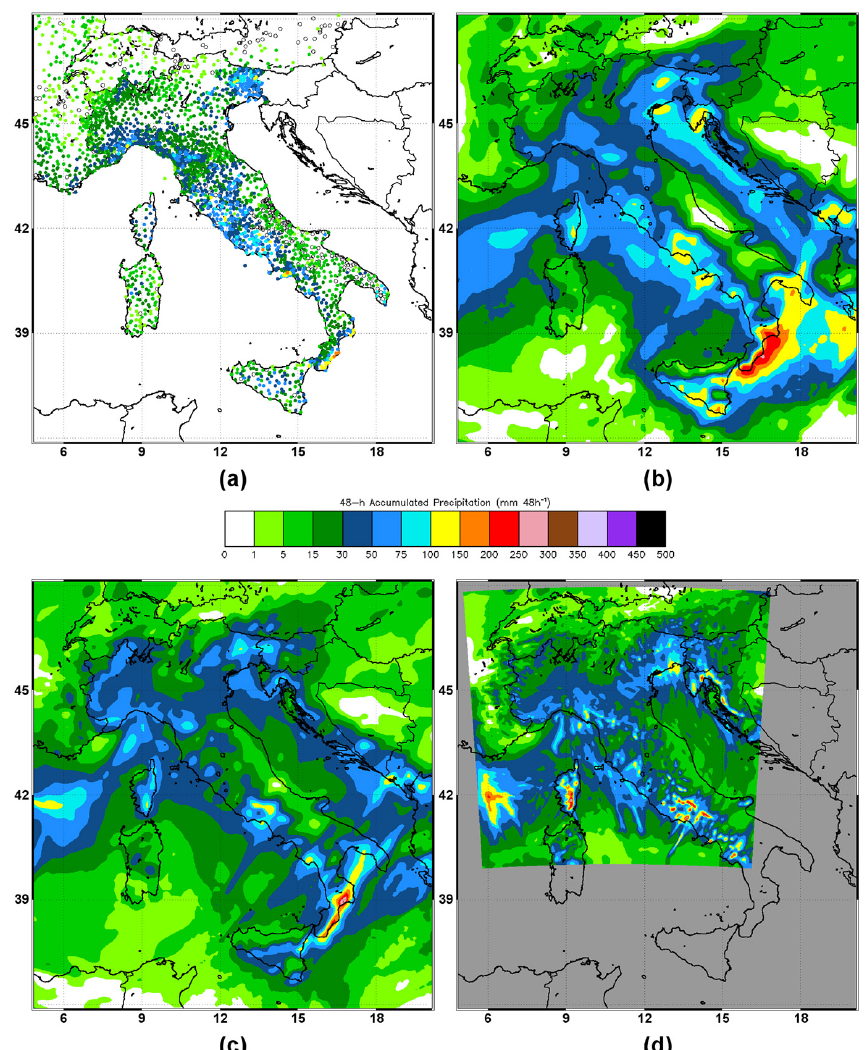
Figure 10. As in Fig. 8, but for the 48h accumulated precipitation starting at 00:00UTC of 31 October 2012. The forecasts were initialised at 12:00UTC on 30